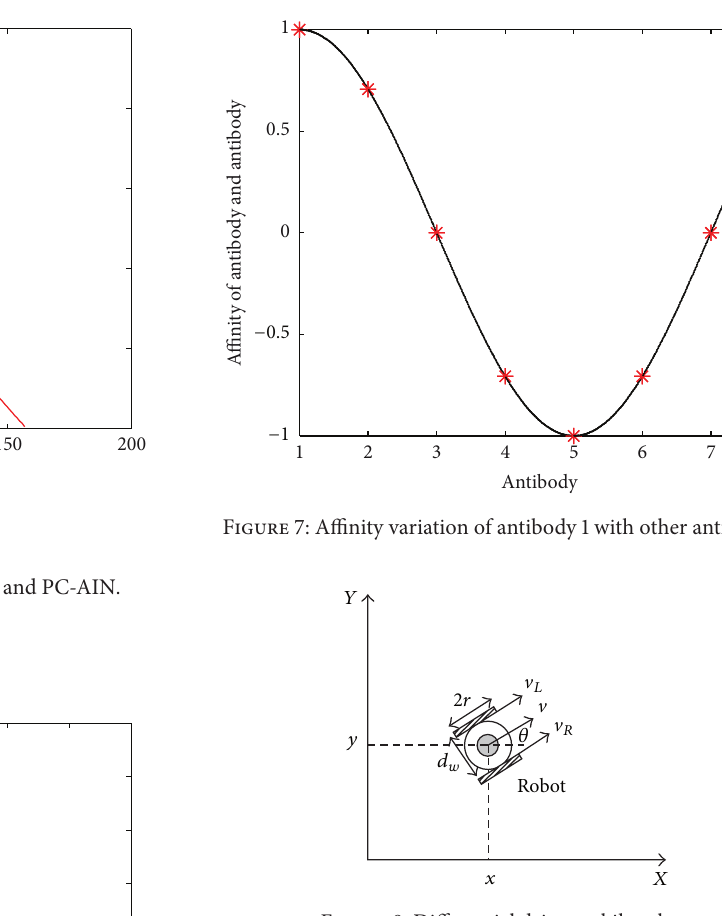
Figure 8: Differential drive mobile